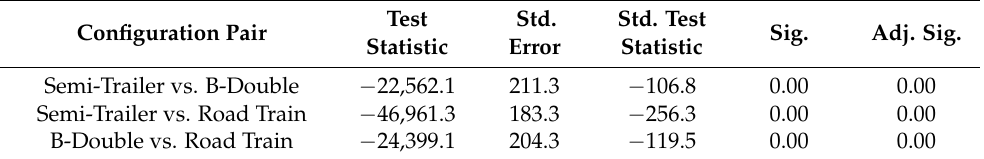
Table 6. Tare weight pairwise comparison of configurations for being the same